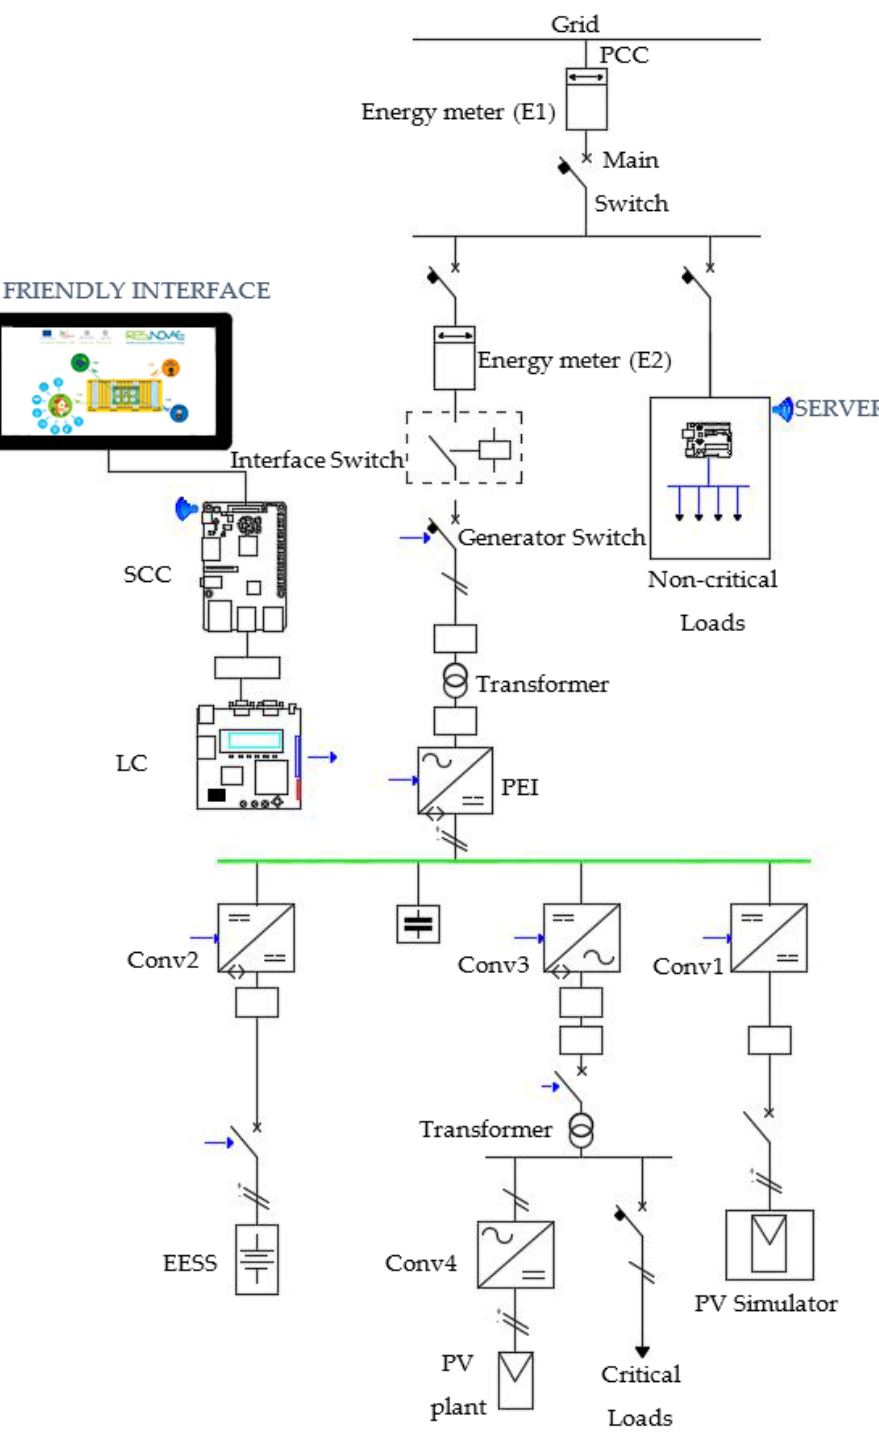
Figure 6. The SUN configuration installed at the pilot site.